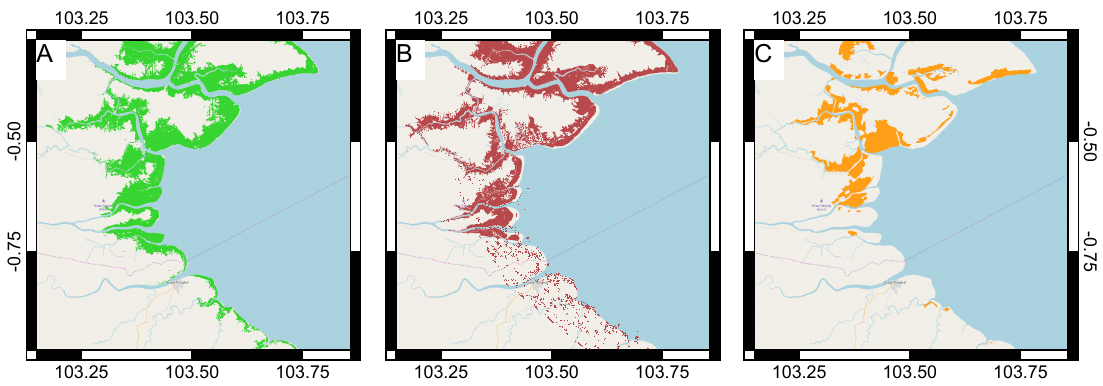
Figure 7. Riau/Jambi in Sumatra, Indonesia: ( A ) GMW v2.0 baseline; ( B ) Giri et al. [1]; and ( C ) Spalding et al. [2], illustrating differences between the three datasets. Background maps: Open Street Map (https://www.openstreetmap.org).